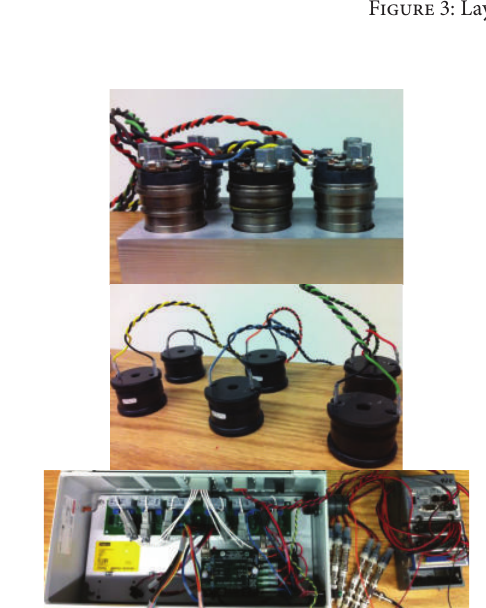
Figure 4: Injector stators used as load (top). Inductors that emulate real injectors as load (middle). FPGA hardware to capture the injection signal